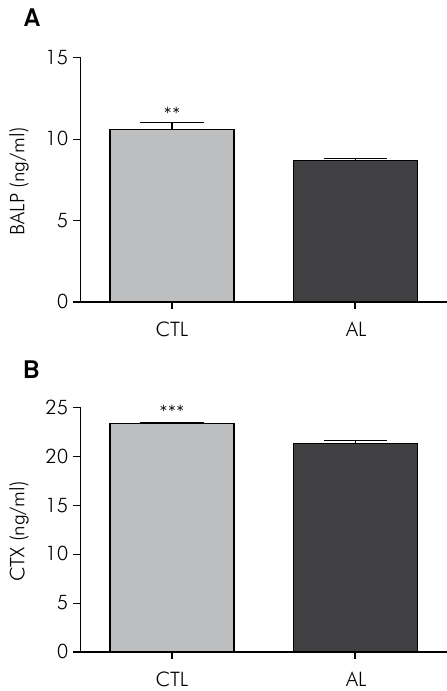
Figure 7. Levels of BALP (A) and CTX (B) in experimental groups at 28 days after tooth extractions. In the CTX analysis, animals in the CTL group presented levels statistically significantly higher than those of animals in the AL group (***p < 0.001). In the BALP analysis, CTL animals exhibited increased levels of BALP compared with those in the AL group (**p <